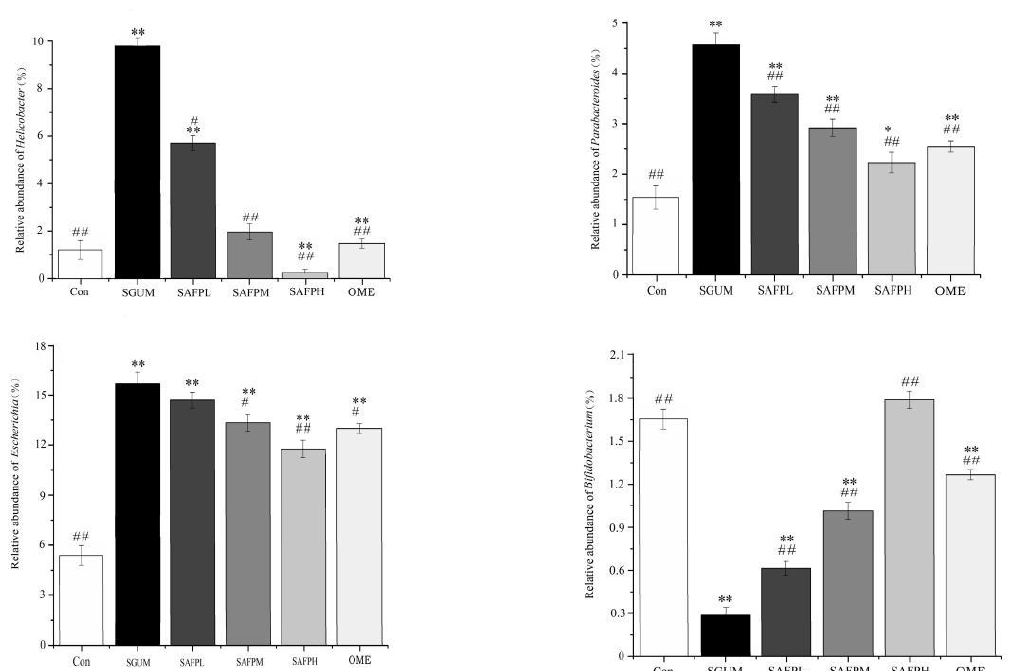
Figure 8. SAFP modulated the composition and structure of caecal microbiota ( n = 5). ( A ) Relative abundance of bacteria at the phylum level. ( B ) Relative abundances of predominant phylum by heatmap analysis. ( C ) Effects of SAFP on the relative abundance of Firmicutes, Actinobacteria, Pro- teobacteria and Verrucomicrobia. ( D ) Relative abundance of bacteria at the genus level. ( E ) Relative abundances of predominant genus by heatmap analysis. ( F ) Effects of SAFP on the relative abundance of Bacterodies, Lactobacillus, Oscillospira, Akkermania, Helicobacter , Parbacterodies, Escherichia and Bifidobacterium. * p < 0.05, ** p < 0.01, vs. control group. # p < 0.05, ## p < 0.01, vs. SGUM group. SAFPL group represents SAPF low-dose group (100 mg/kg BW); SAFPM group represents SAFP middle-dose group (200 mg/kg BW); SAFPH group represents SAFP high-dose group (400 mg/kg BW).